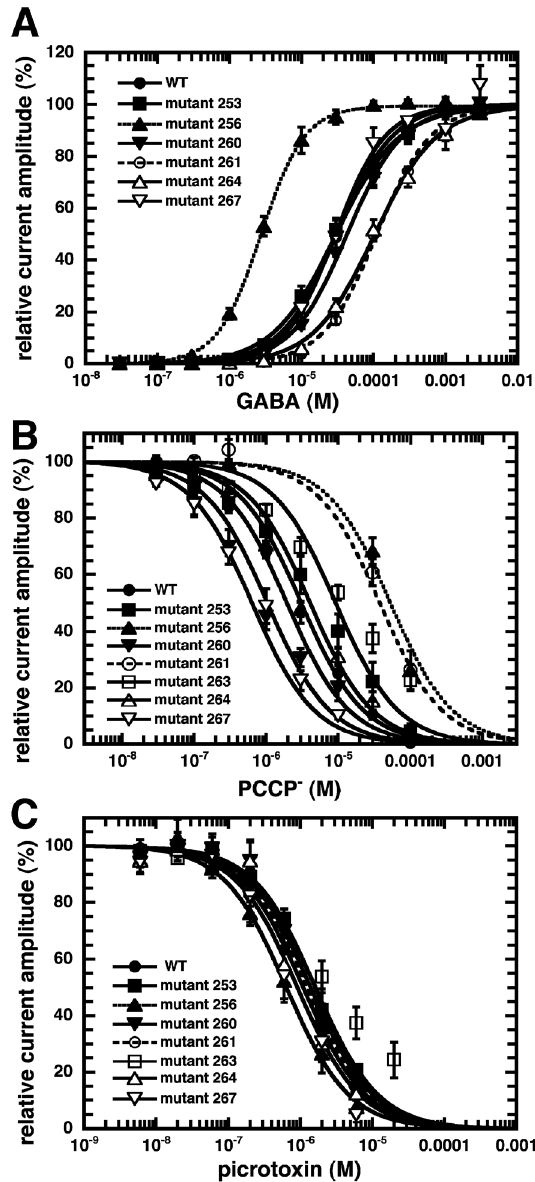
Figure 7. Pharmacological properties of wild type and cysteine mutant GABA A receptors. A, GABA concentration response curves from wild type and mutant rat GABA A receptor. B, PCCP 2 and C, picrotoxin concentration inhibition curves. Individual curves were fitted and standardized. Data are shown as mean 6 SD (n=3 to 4).